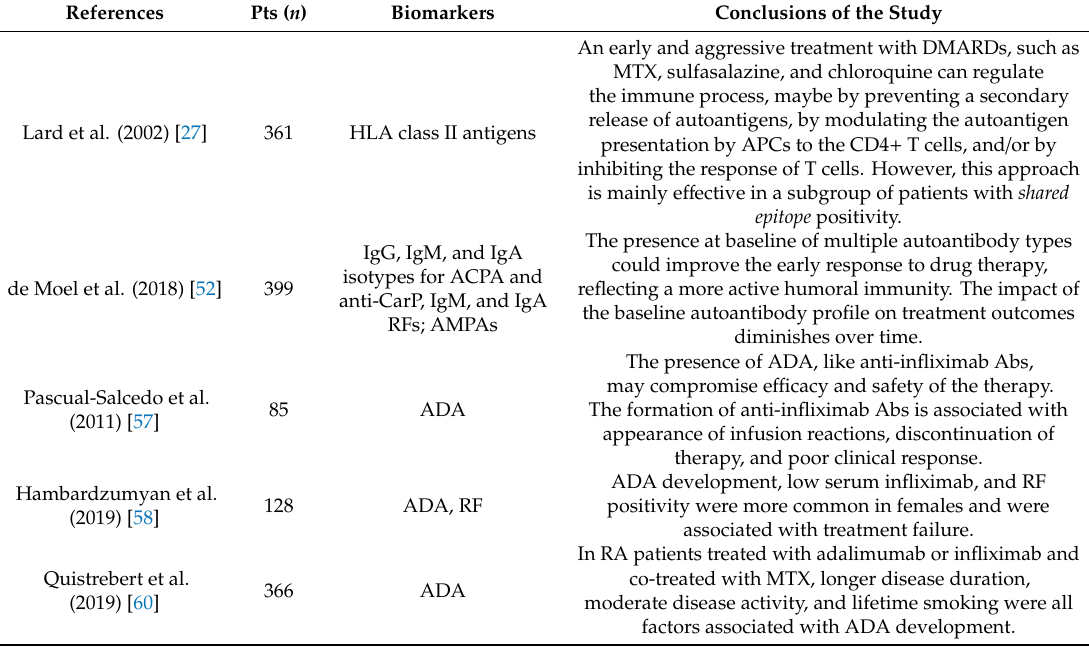
Table 1. Studies on association between autoantibodies and treatment outcomes in patients with rheumatoid